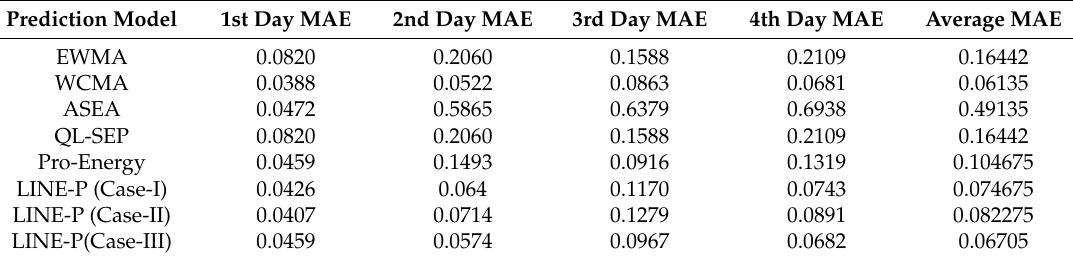
Table 2. MAE of the LINE-P (all cases) and other prediction models for solar